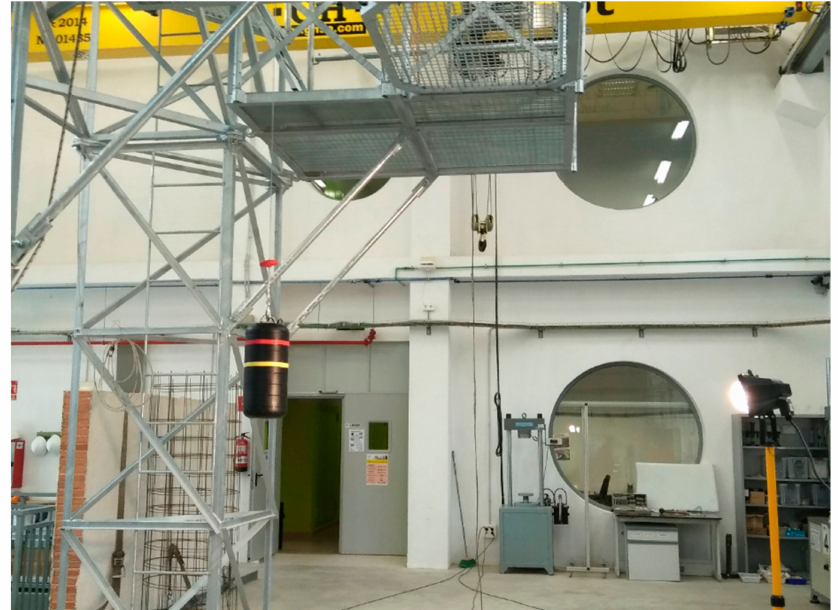
Figure 4. Test bench and